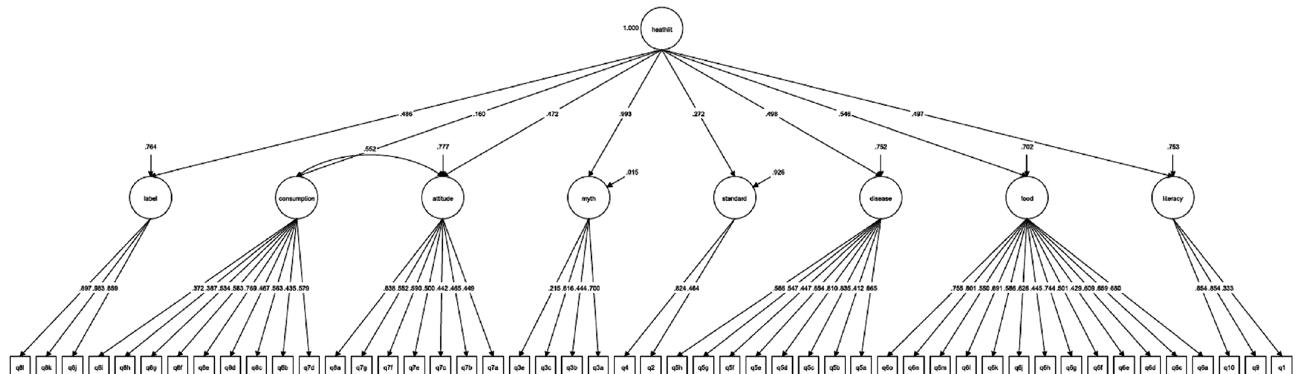
Fig 2. Factor structure of the Chinese Health Literacy Scale for Low Salt Consumption — Hong Kong population (CHLSalt-HK).